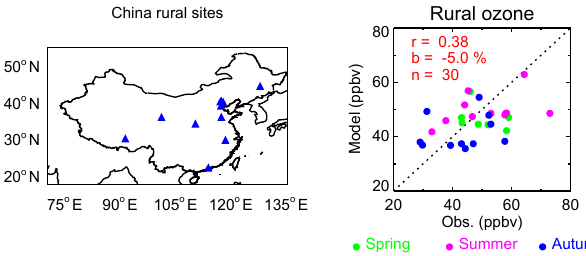
Figure 3. Evaluation of simulated [O 3 ] at rural sites in China. Sim- ulation results are from G10ALLNO3 performed with the climate model ModelE2–YIBs (Table 2). For the scatter plots, green, pink, and blue points represent values in spring, summer, and autumn, respectively. The data sources of all sites are listed in Table